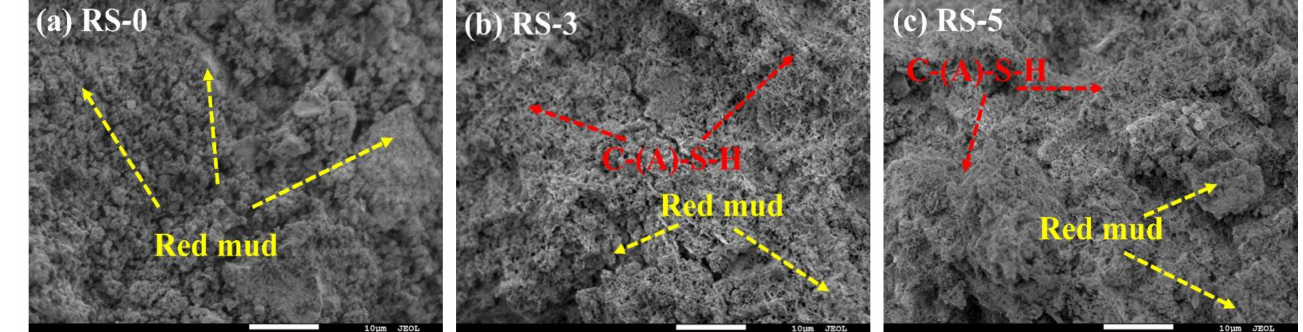
Figure 9. SEM images of ( a ) RS-0; ( b ) RS-3; and ( c ) RS-5 at the curing age of 28 days.